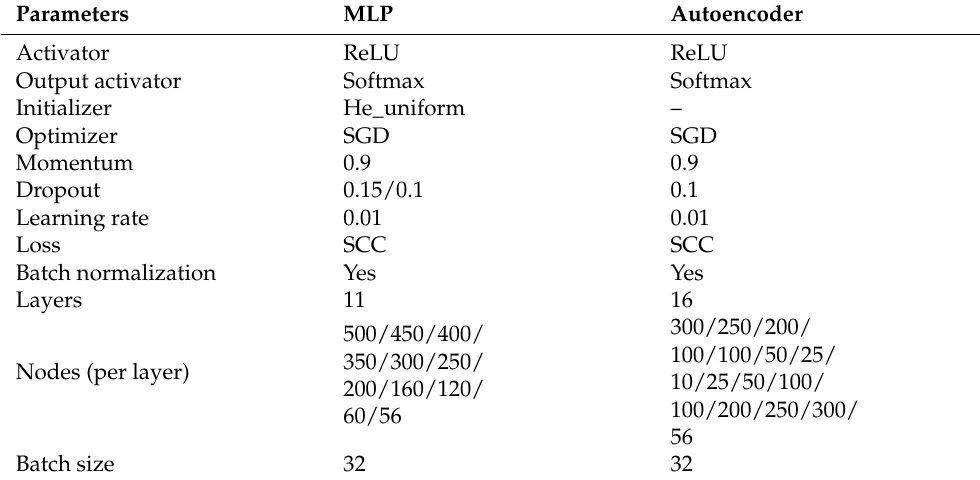
Table 5. DNN classification parameters per model.